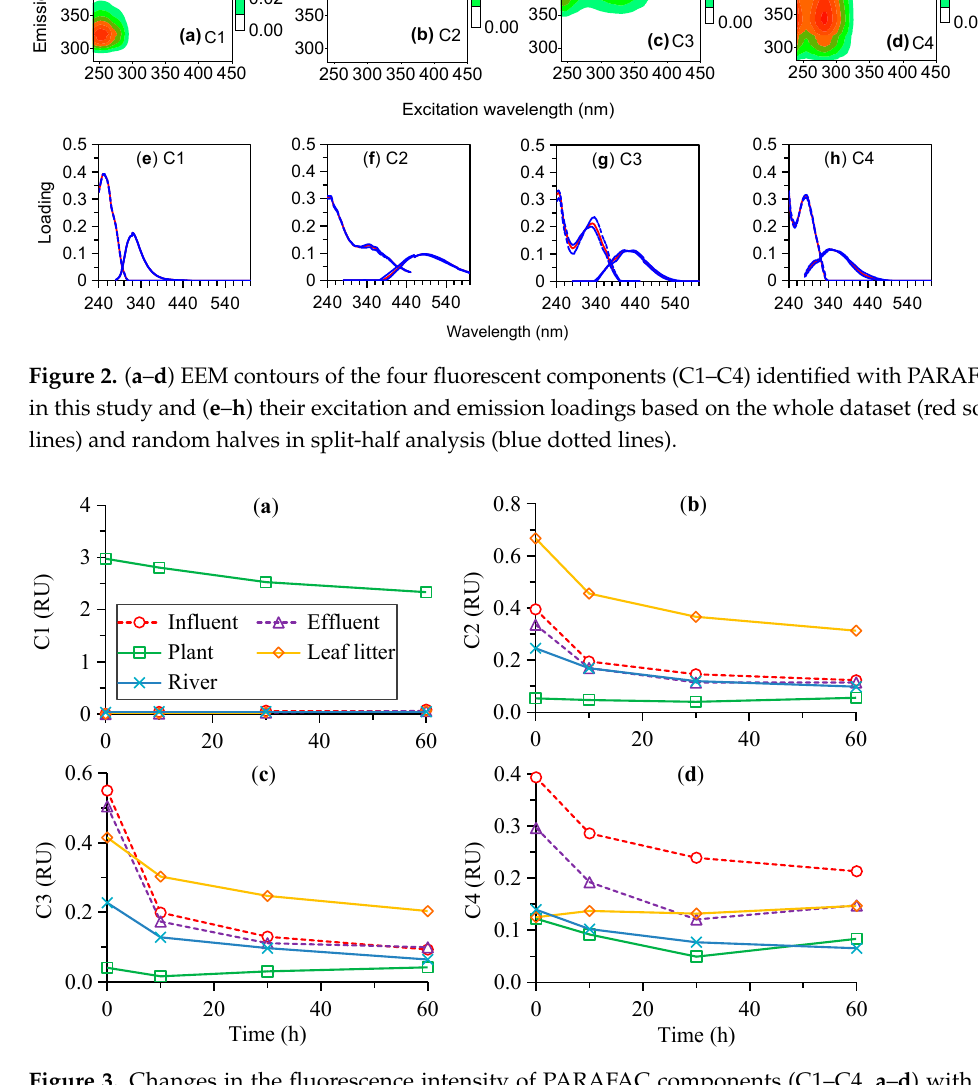
Figure 2. ( a – d ) EEM contours of the four fluorescent components (C1–C4) identified with PARA-